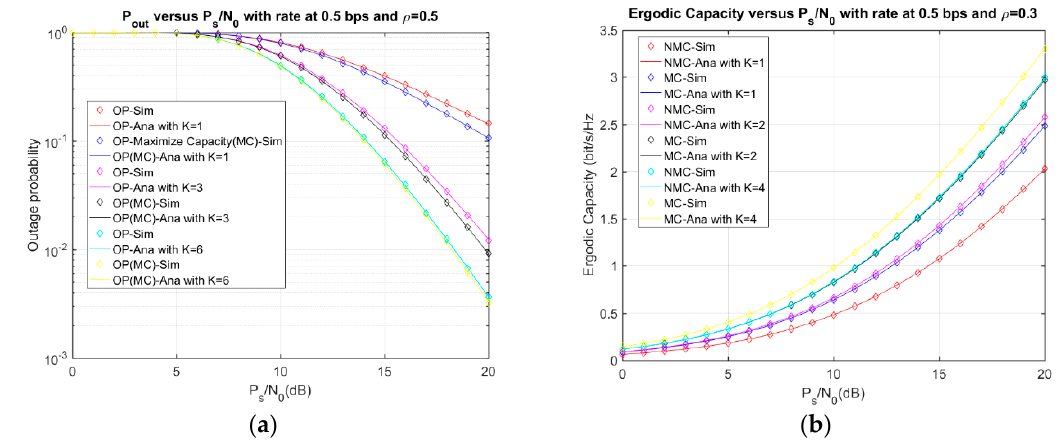
Figure 4. The outage probability ( a ) and ergodic capacity ( b ) versus P s /N 0 while ρ = 0.5.